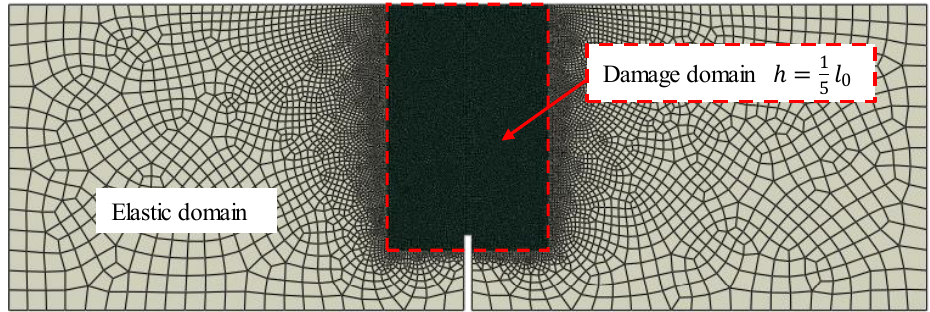
Figure 5. Notched concrete beam: geometry, loading and boundary conditions.